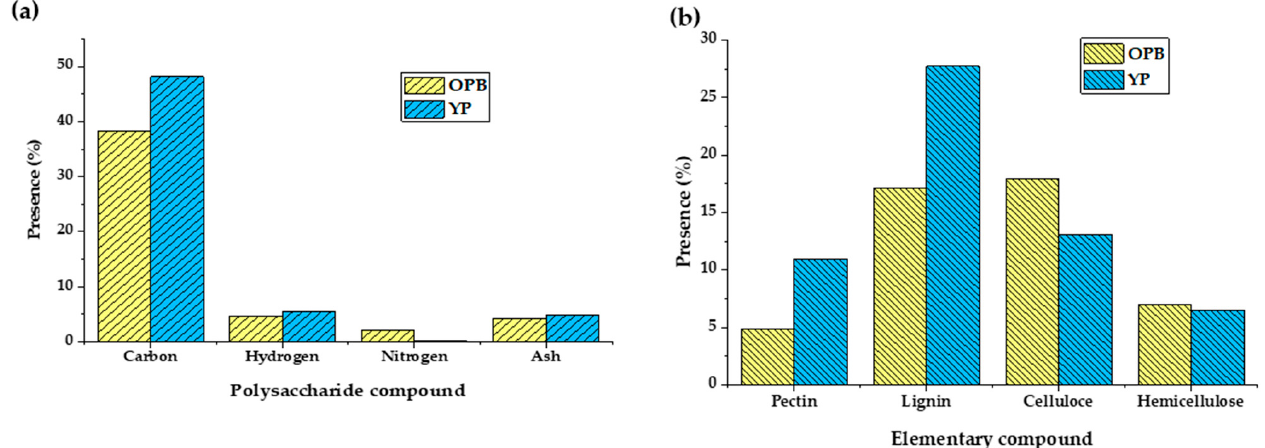
Figure 1. Bromatological analysis of OPB and YP: ( a ) polysaccharide compounds and ( b ) elementary compounds [25,26].